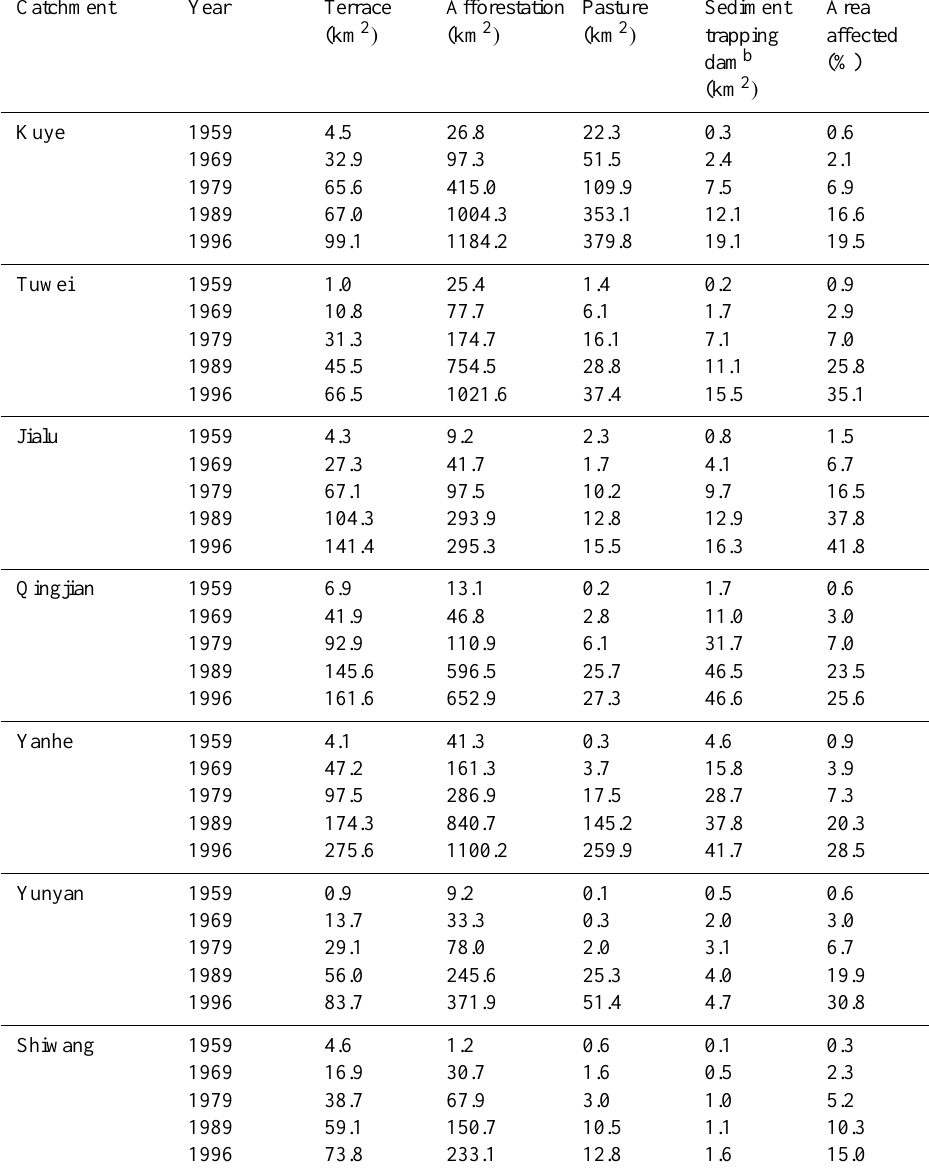
Catchment Year Terrace